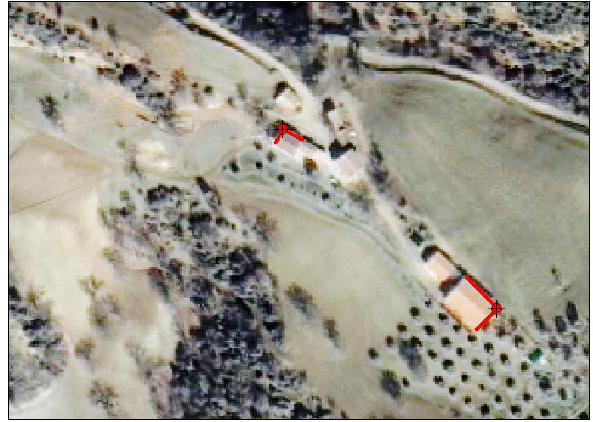
Figure 10. Control points in the second step on test 1